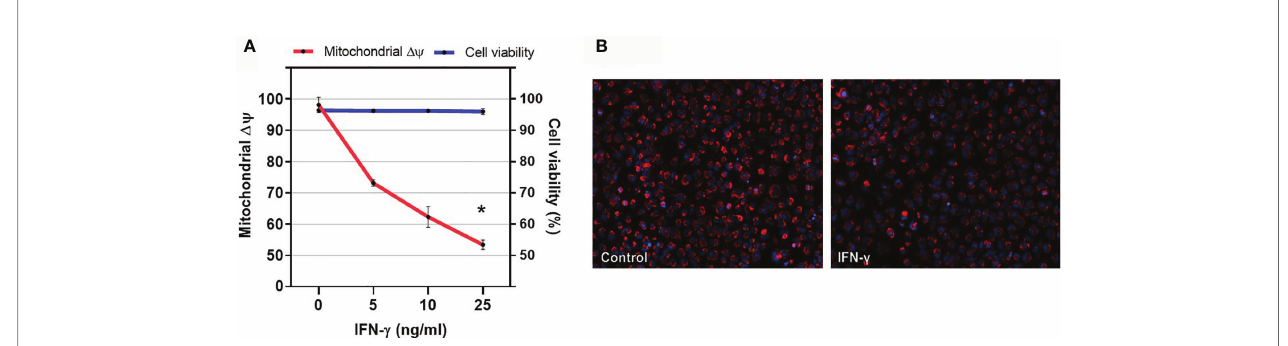
FIGURE 6 | Effect of IFN-gamma on cardiomyocyte mitochondrial membrane potential. (A) Human cardiomyocytes AC16 were stimulated with 5, 10 or 25ng/ml of IFN-gamma for 48 hours. Then, cells were stained using 1µM TMRM, 400nM of mitotracker DeepRed, 500ng/ml of PI and 1µM of Hoechst 33342 and micrographs were captured in ImageXpress Micro XLS Wide fi eld High-Content Analysis system at 100x magni fi cation. Fluorescence colocalization of TMRE and mitotracker deepred in live cells (PI negative) was used to calculate mitochondrial DY . Data are reported as the ratio to not-treated cells. Cell viability is the ratio of the number of live cells (PI-negative) and total cells (PI-negative plus PI-positive cells) x 100. n = 3. *p < 0.05. (B) Representative fl uorescence microscopy (100x) showing decrease in TMRE fl uorescence after incubation with IFN-gamma for